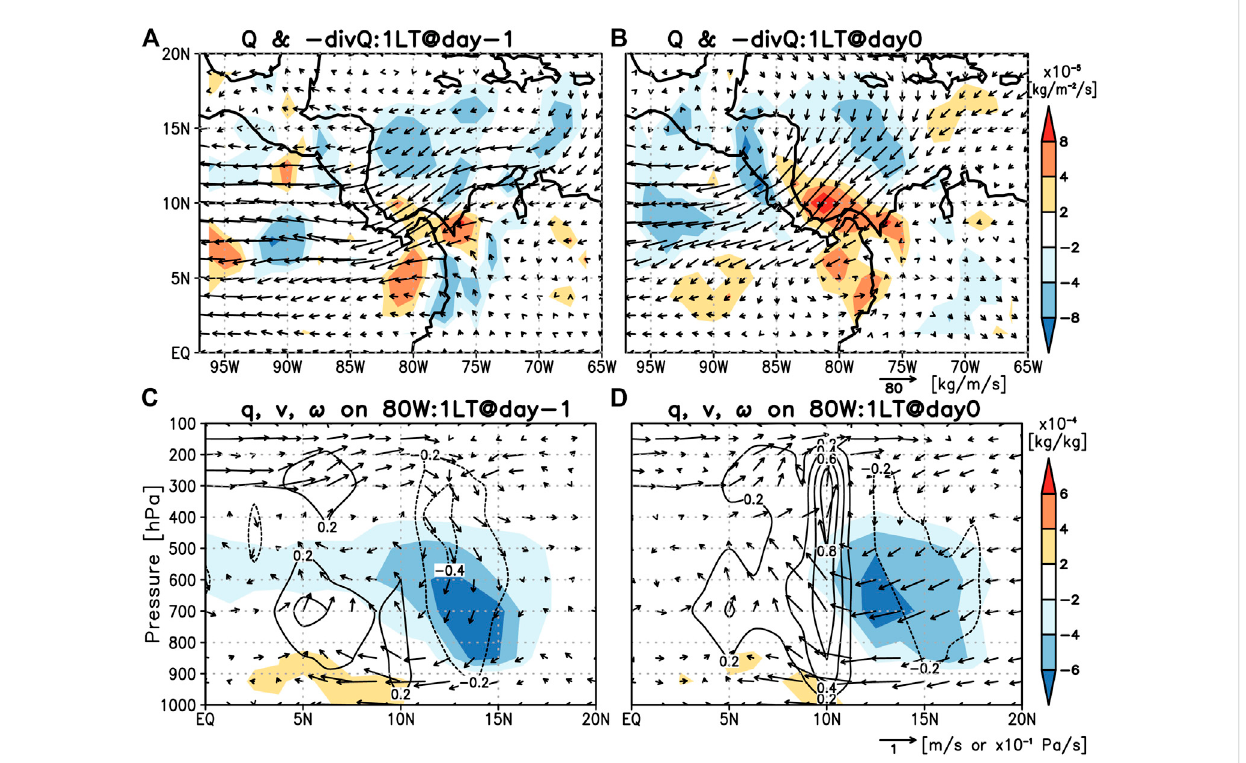
FIGURE 8 Composited vertically integrated moisture fl uxes (vectors) and their convergence (shades) at 1 LT on day-1 (A) and day0 (B) . A vertical cross section of the meridional and vertical motion of the winds and speci fi c humidity at 80 ° W on day-1 (C) and day0 (D) . The composite was conducted with MRI- AGCM 3.2 and anomalies from the normal state are shown.